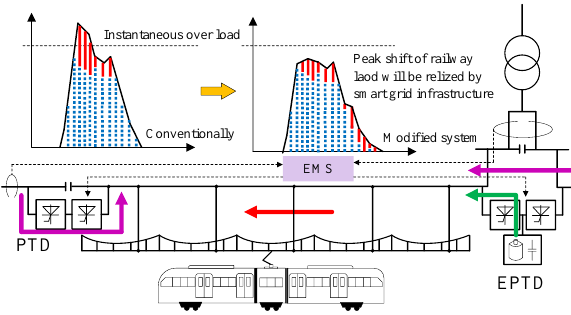
Figure 7. Peak shaving based on the modified system.